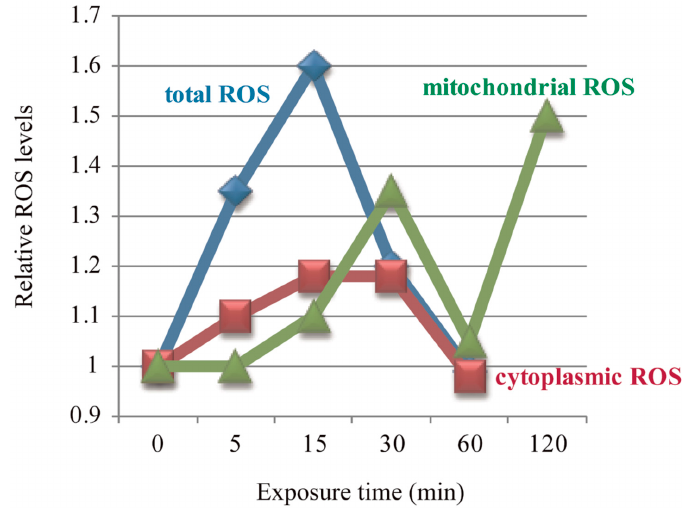
Figure 1. Electromagnetic fields (EMFs)-induced ROS level changes were time-dependent. Figure was made based on results from References [56–58].